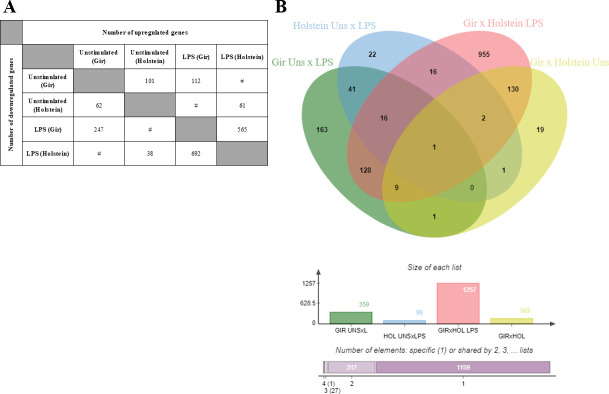
Overview of transcription data from MDMs of Holstein and Gir breeds.(A) Summary of numbers of upregulated and downregulated genes (FDR<0.05, LogFC≥1) determined by amounts of evaluated transcripts (CPM>1) between in vitro unstimulated and LPS (100 ng/ml) treated MDMs from Holstein (n = 4) and Gir (n = 4) MDMs. “#” denotes unrated contrasts. (B) Venn diagram showing DEGs (FDR<0.05, LogFC≥1) shared among all evaluated contrasts. Green diagram: unstimulated versus LPS treated Gir MDMs. Blue diagram: unstimulated cells versus LPS treated Holstein MDMs. Pink diagram: LPS treated Holstein versus Gir MDMs. Yellow diagram: unstimulated cells Holstein versus Gir MDMs. The graphic bars show the total number of DEGs for each contrast in the Venn diagram followed by numbers of specific genes in each contrast or shared between two, three or four contrasts.